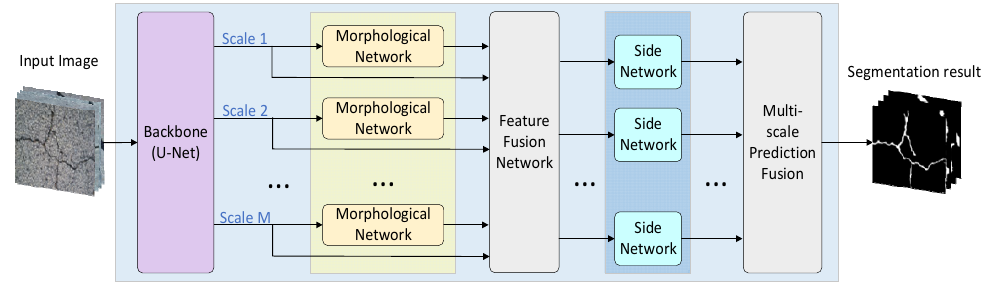
Figure 1. Schematic diagram of crack segmentation method.